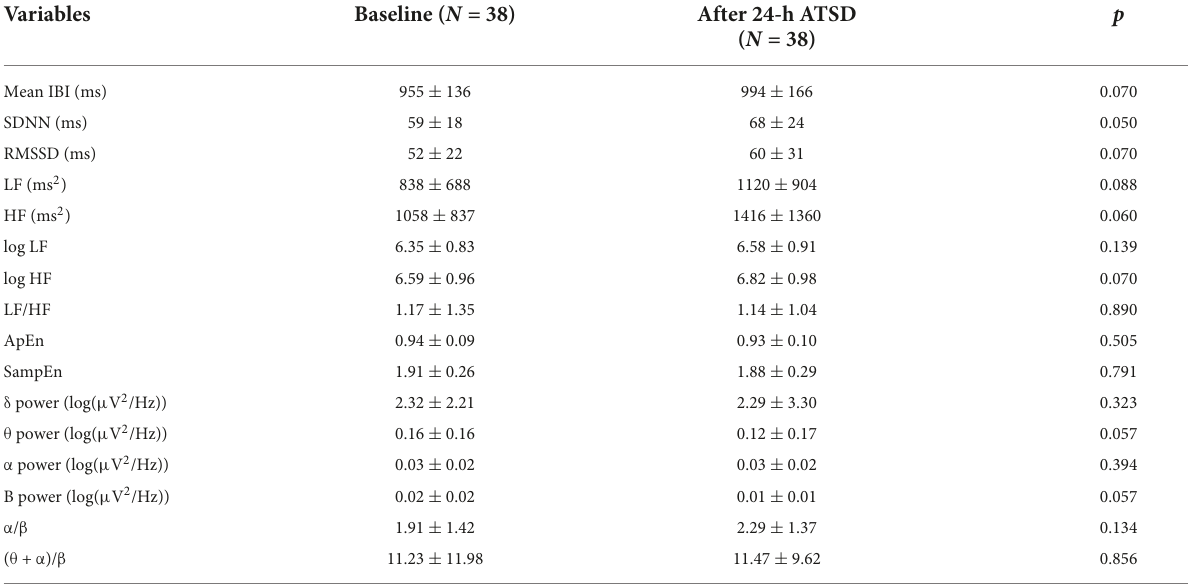
TABLE 2 Mean ± standard deviation of heart rate variability (HRV) parameters and electroencephalography (EEG) band power ratios in the supine position before and after 24-h acute total sleep deprivation (ATSD) for 38 healthy participants. Variables Baseline ( N = 38) After 24-h ATSD ( N = 38)